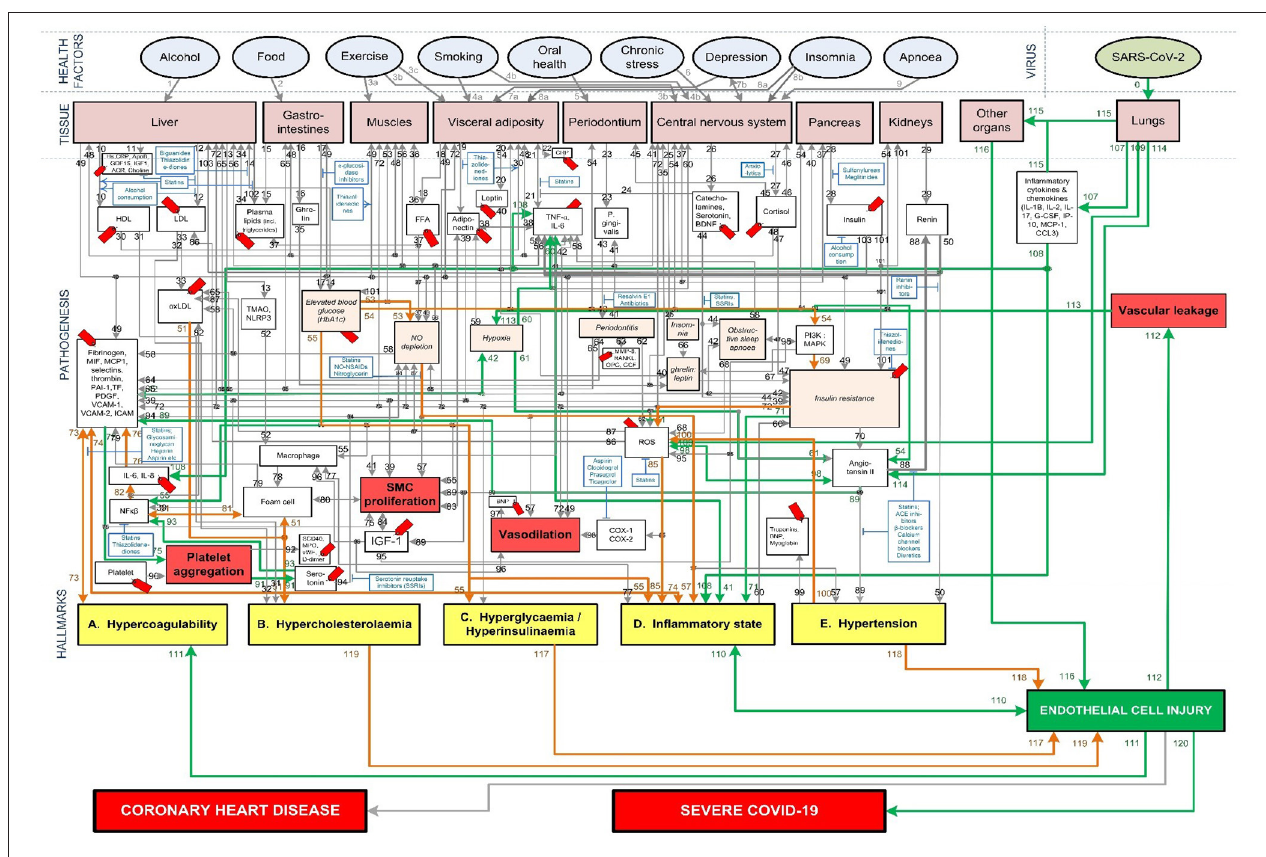
FIGURE 4 | Proposed integrated Covid-19/CHD